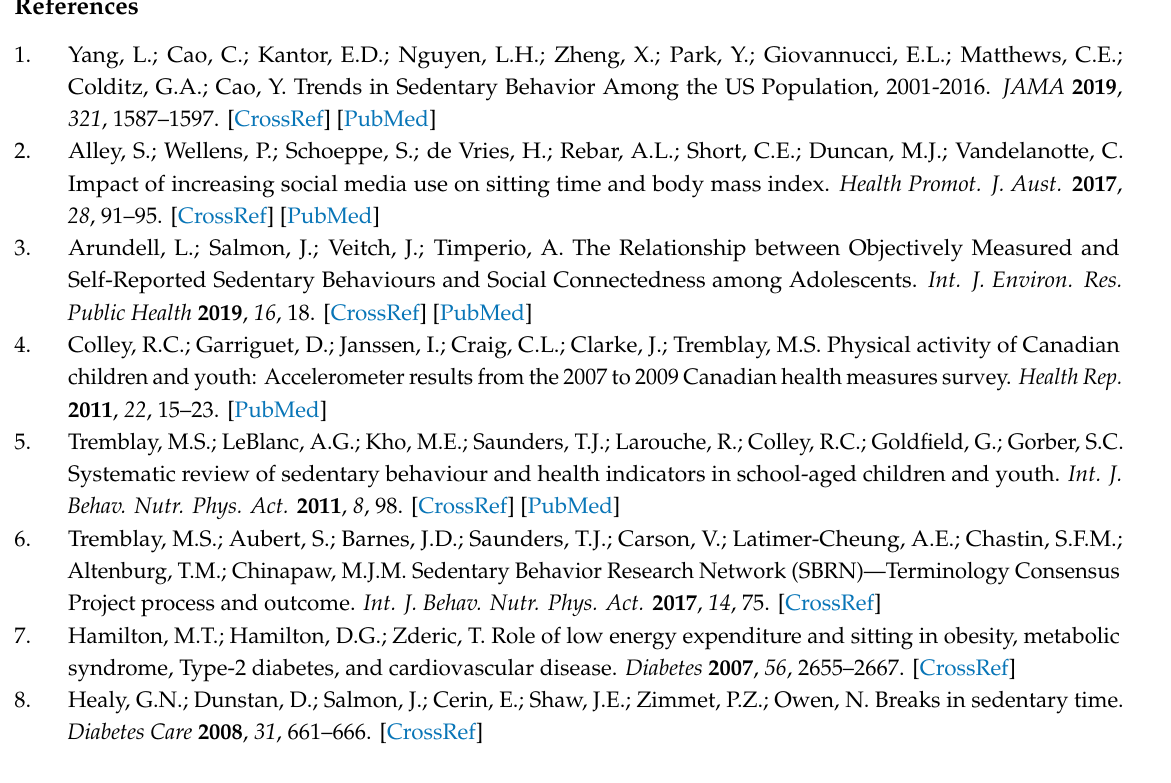
Table S1: Standing and sitting time at the start and the end of the school